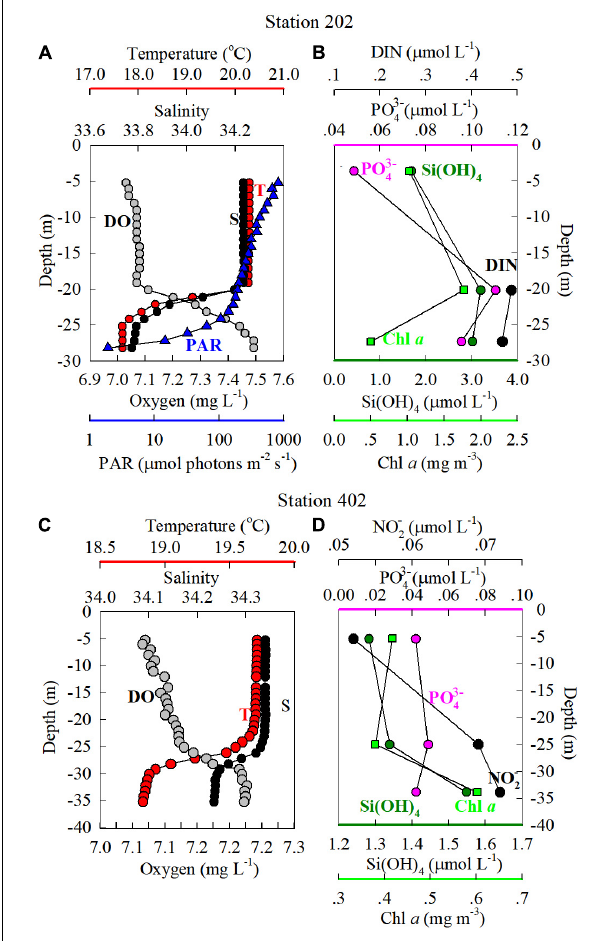
FIGURE 4 | Vertical profiles of T ( ◦ C), S, dissolved oxygen (DO, mg L − 1 ) (A,C) , DIN, PO 43 − , and Si(OH) 4 ( µ mol L − 1 ) and Chl a (mg m − 3 ) (B,D) at stations s202 and s402 (see Figure 1 ) in the NSCS shelf, winter 2008. Chl a concentrations were determined using a Turner fluorometer fitted with a red-sensitive photomultiplier (Parsons et al., 1984). The irradiance (photosynthetically active radiation, PAR, in µ mol photons m − 2 s − 1 ) at station s202 sampled at 12:40 (GTM + 8) in the afternoon is also shown in Figure 4C ; PAR at station s402 is not shown as the sampling time was at 19:20 (GTM + 8) in the evening. The blue dashed line indicates the 27 m depth where the irradiance was 1% of surface PAR which could support about half of the light-saturated primary productivity (Xie et al., 2015). Values of T, S, DO, and PAR were determined using a conductivity-temperature-depth (CTD) recorder per meter throughout the whole water column. The DIN concentration in the surface layer at s202 ( Figure 4B ) was below the limit of 0.1 detections, but it was quite high in the bottom